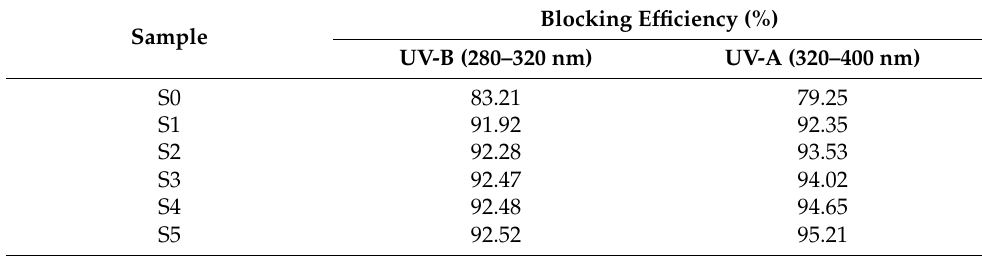
Table 1. Blocking efficiencies of samples in the UV-A and B